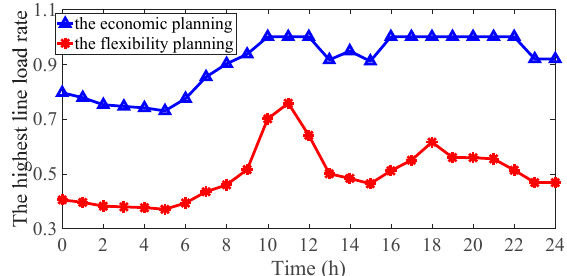
Figure 4. The highest line load rate of the power grid.